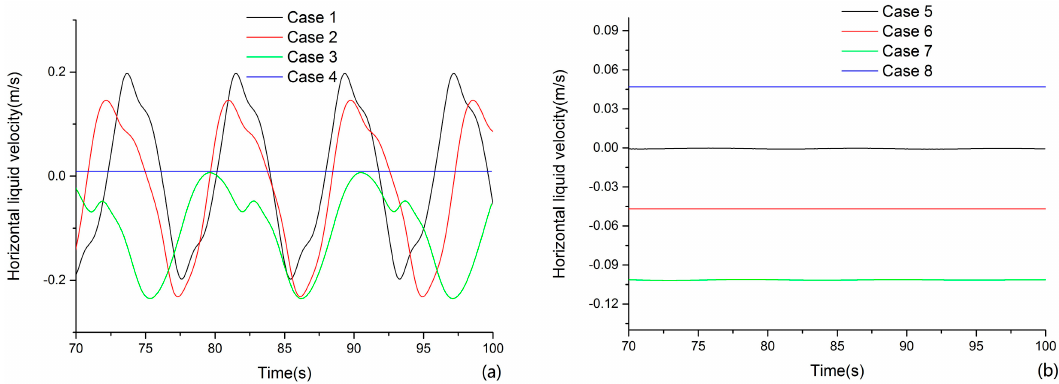
Figure 8. Instantaneous horizontal velocity of the liquid phase at the monitoring points: ( a ) cases 1–4 and ( b ) cases 5–8.